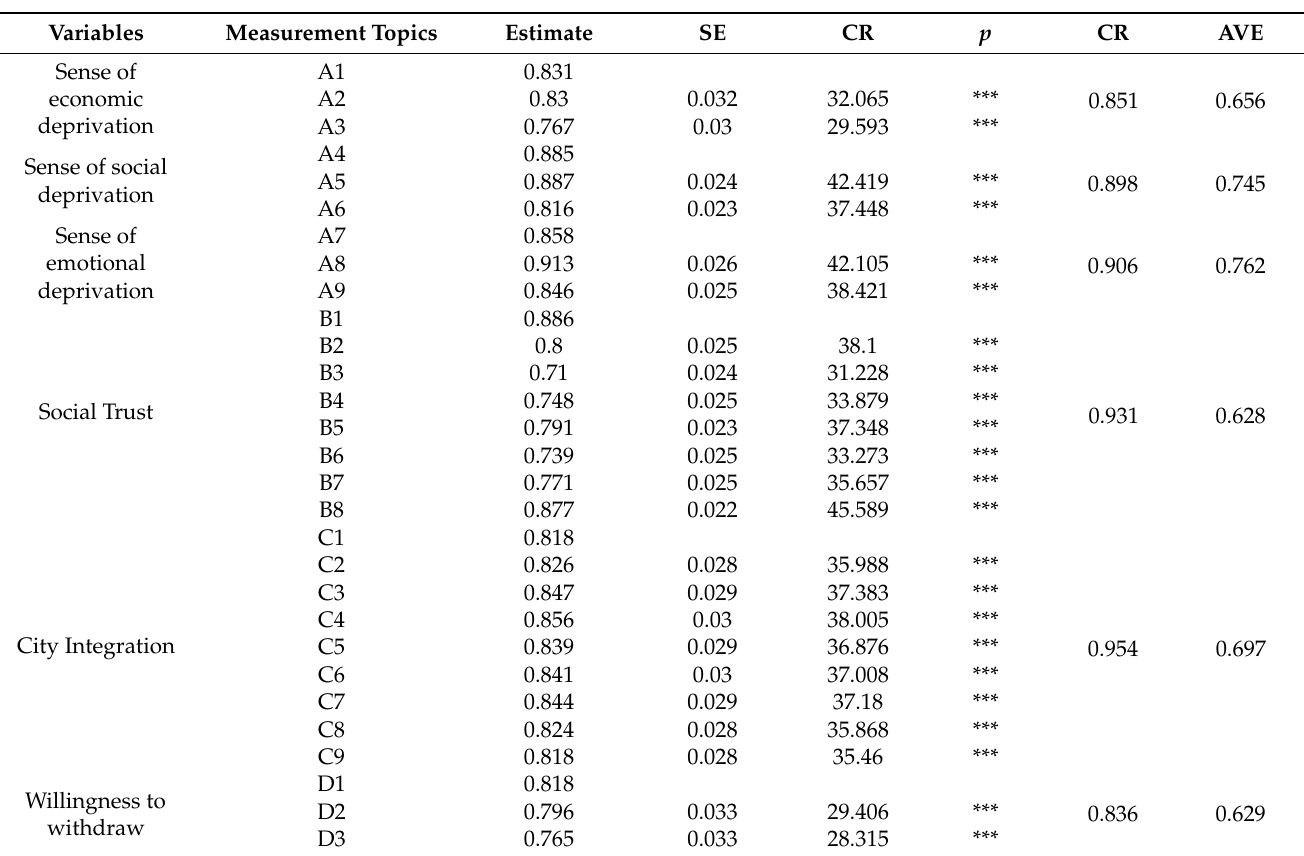
Table 6. Factor analysis